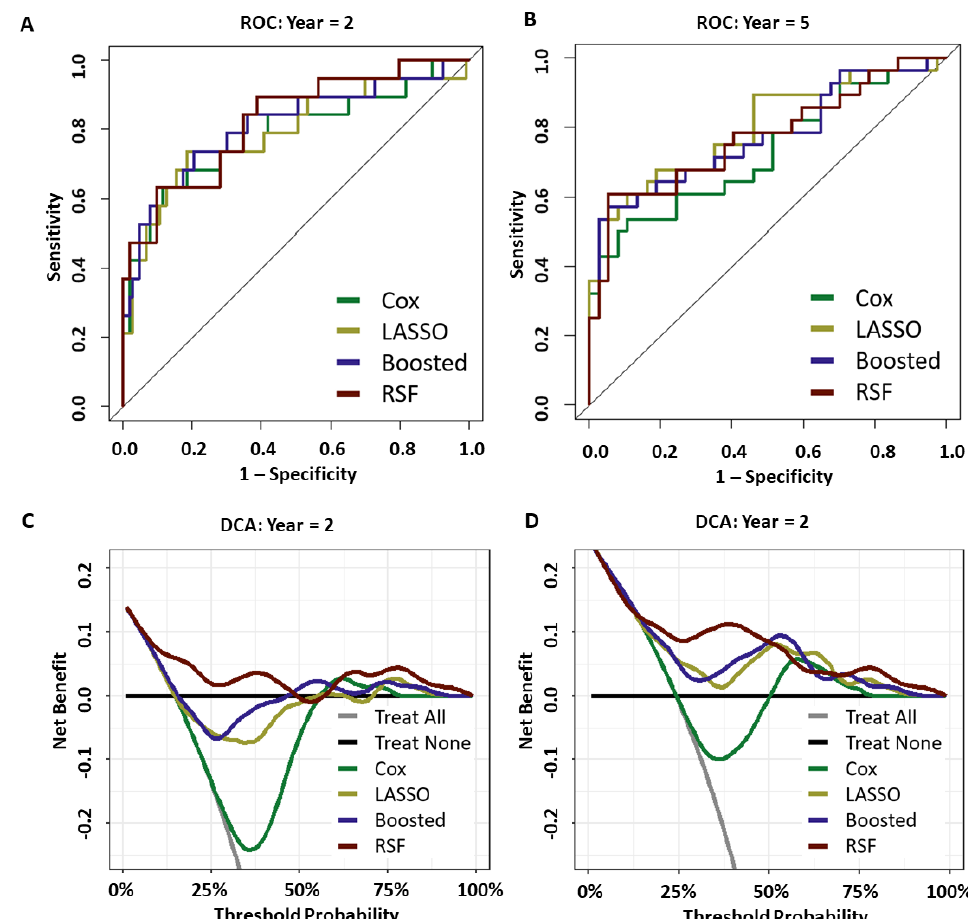
Figure 3. ( A , B ): ROC for 2-year ( A ) and 5-year ( B ) horizons. ( C , D ): DCA curves at the same